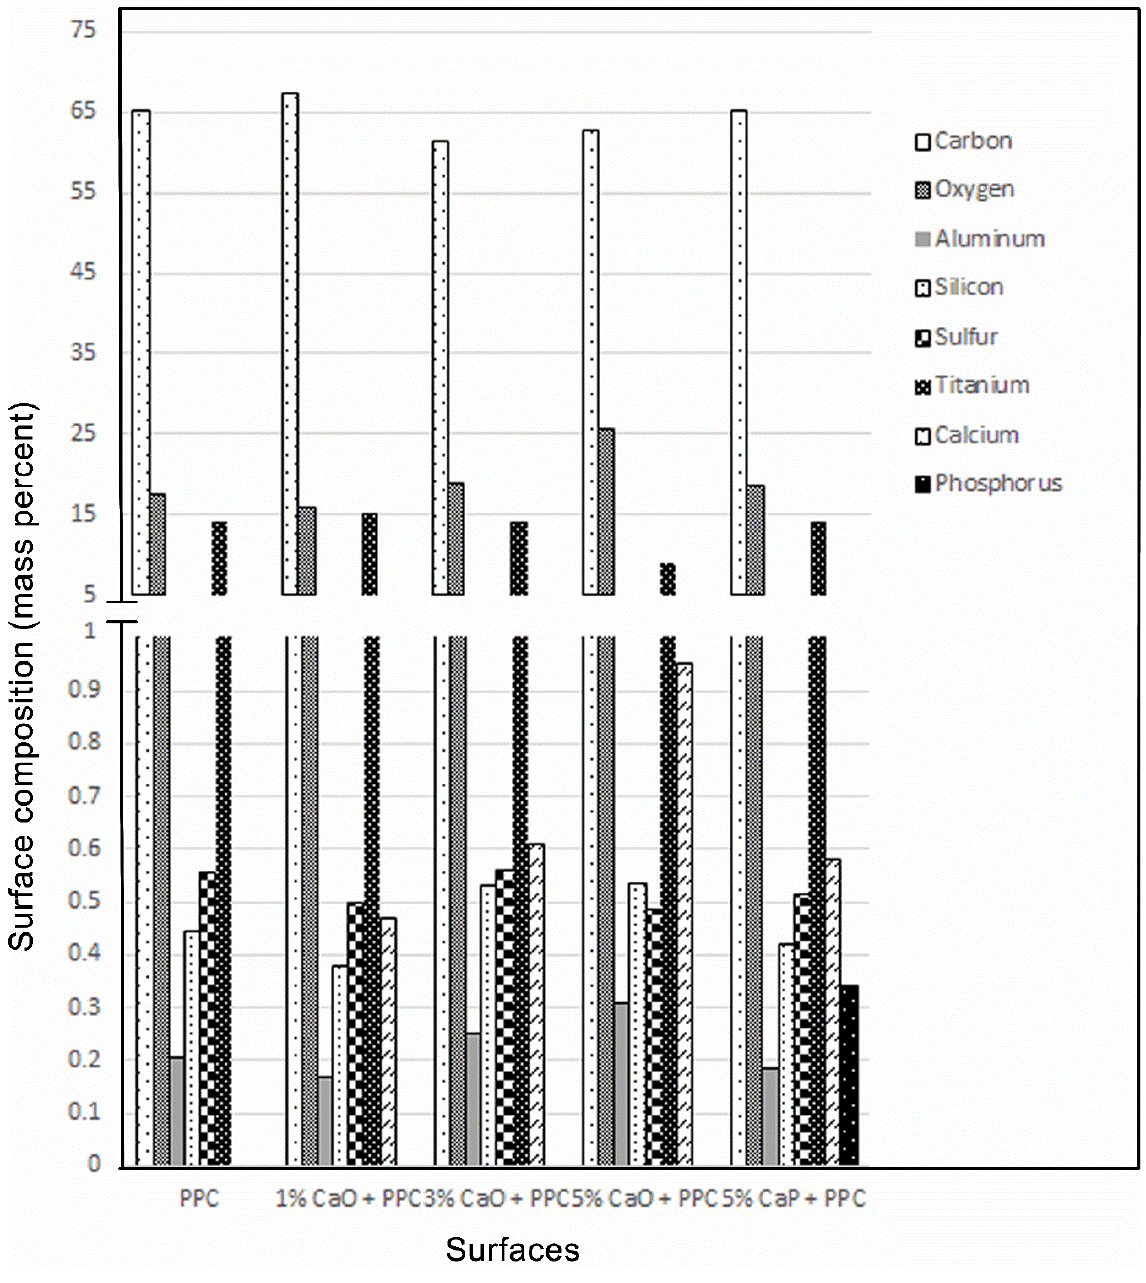
Figure 3. EDX was used to detect the presence of various elements on coated surfaces. This analysis demonstrated that the surface coating particles were composed mostly out of carbon, oxygen, and titanium. However, there are smaller quantities of aluminum, silicon, and sulfur that came from the polymer backbone. In addition, the calcium presence increased with the increasing incorporation of calcium oxide, and phosphors were only detected in calcium phosphate-containing mixtures. Collectively, these findings confirmed the accurately of the ultrafine particle technology in incorporation functional